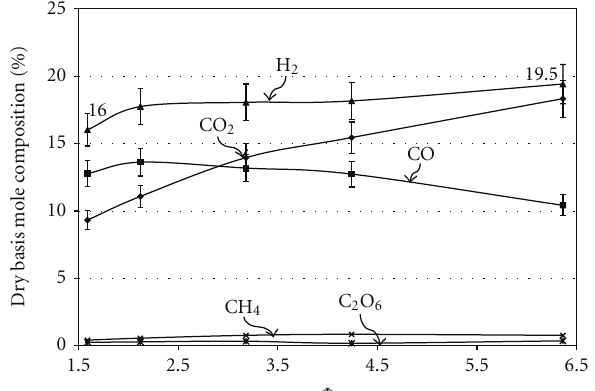
Figure 4: Gas composition of DBWC gasification at S : F = 0 . 40 and several Φ (figure adapted from [11]).